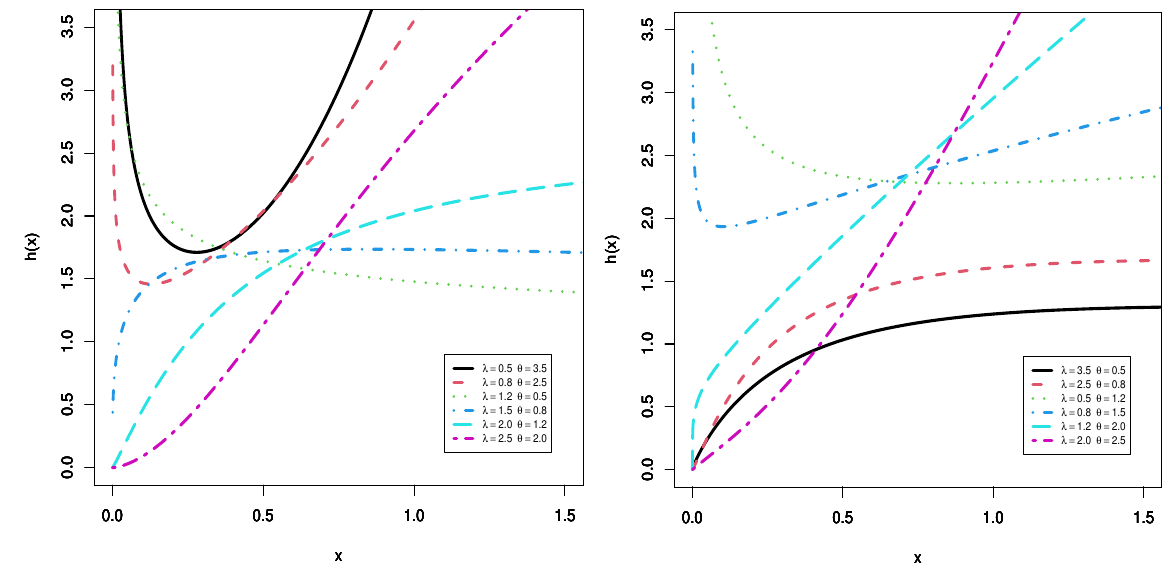
Figure 2. Plots of the hrf for TLMW model at α = β =